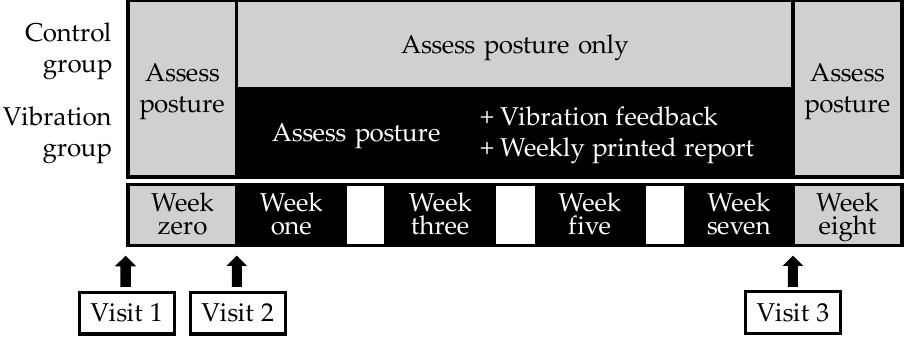
Figure 1. Schematic representation of the eight-week intervention.